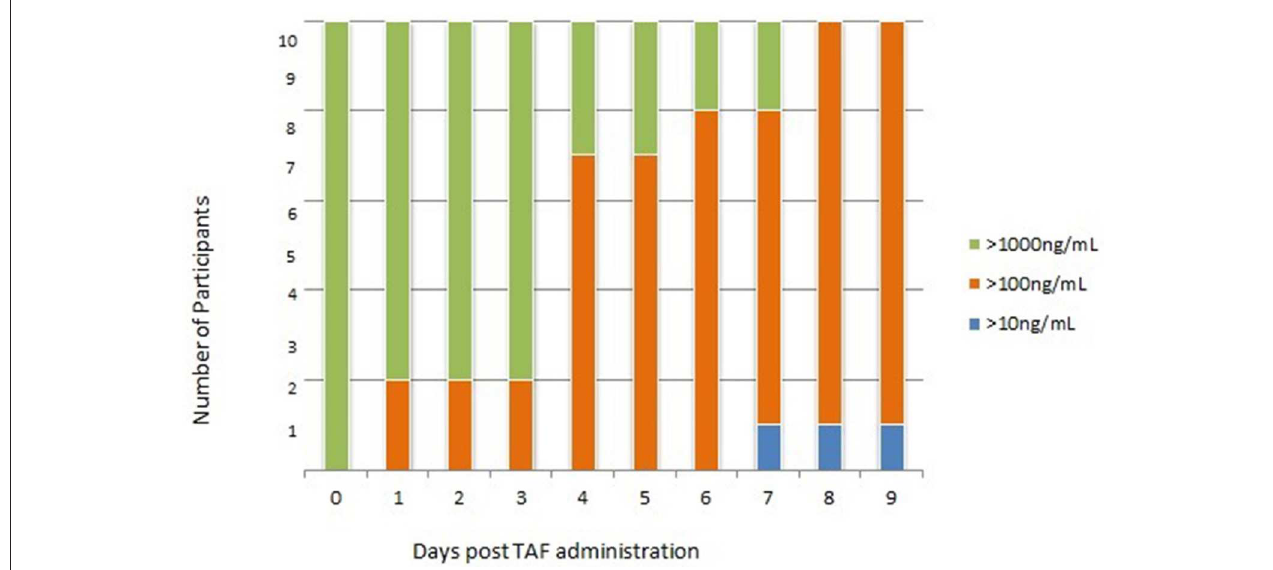
FIGURE 4 | Cohort 3: Urine TFV Concentrations following 7 consecutive doses of FTC/TAF in 10 HIV-subjects. TFV, tenofovir; FTC/TAF, emtricitabine/tenofovir alafenamide; HIV–, Human Immunodeficiency Virus-Negative; TAF, tenofovir alafenamide; ng/mL, nanograms per millimeter.